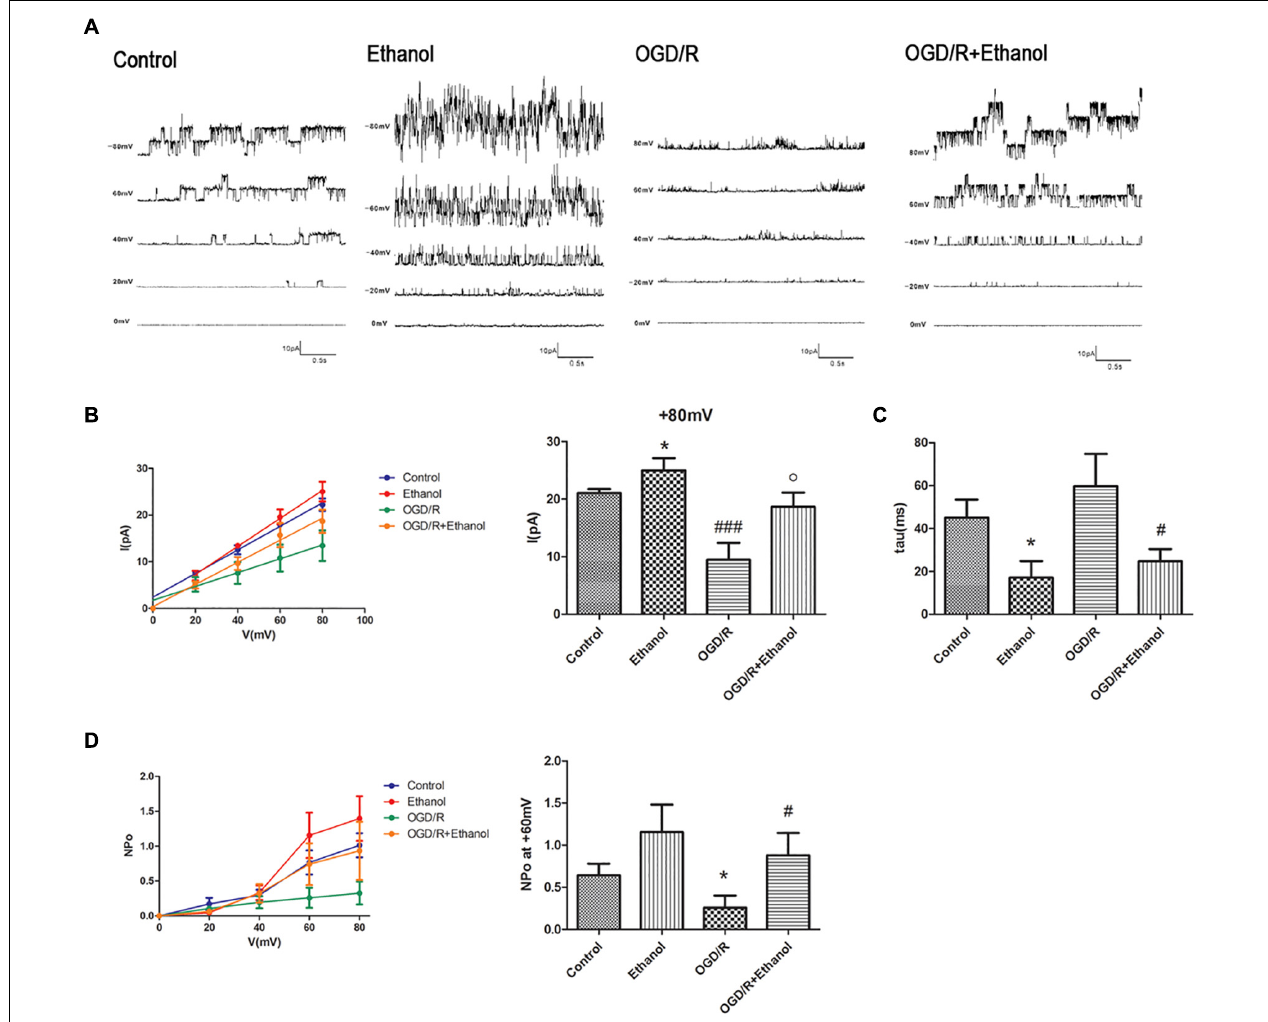
FIGURE 2 | BK Ca mediated the protective effect of ethanol preconditioning. (A) Representative single-channel recordings of BK Ca channels in the inside-out configuration. (B) The current–voltage curve of the BK Ca channels. * P < 0.05 vs. control; ### P < 0.001 vs. control; o P < 0.05 vs. OGD/R. (C) Statistical data for close time of the BK Ca channels. * P < 0.05 vs. control; # P < 0.05 vs. OGD/R. (D) Statistical data for open probability (NPo) of the BK Ca channels. * P < 0.05 vs. control; # P < 0.05 vs. OGD/R.